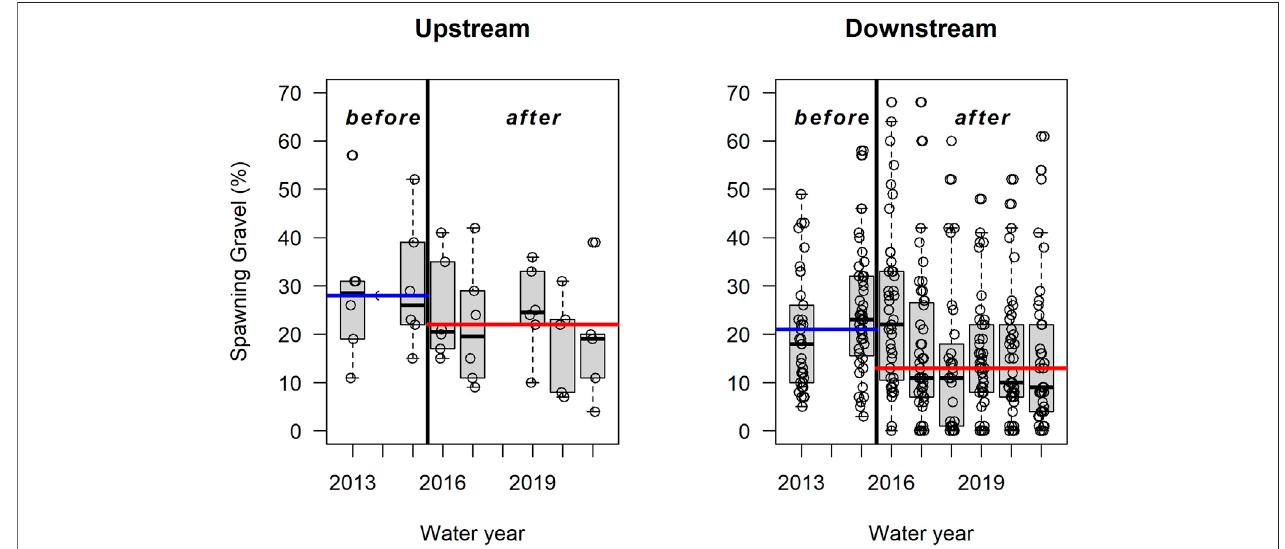
FIGURE5| Boxplotsoftransectpercentspawninggravel(between32and90 mm)attheupstream(control)siteandcombineddownstream(impact)sitesthrough time. Overall before and after median values are shown in colored horizontal lines. Sizes are intermediate axis dimensions.